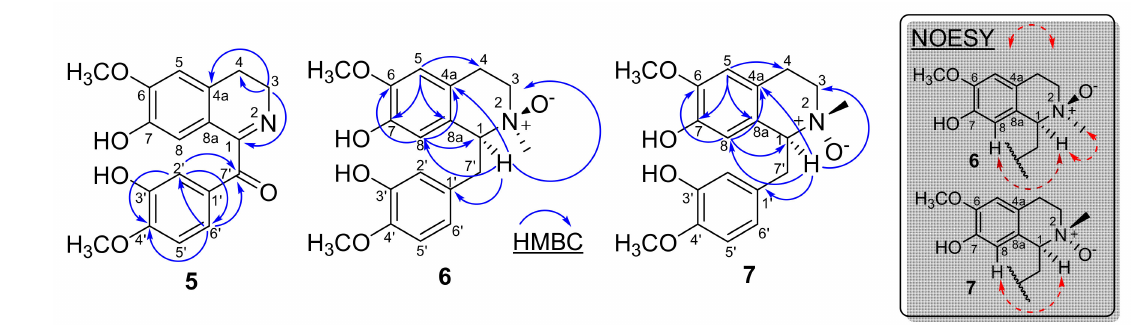
Figure 2. The key HMBC and NOESY correlations in alkaloids 5 – 7